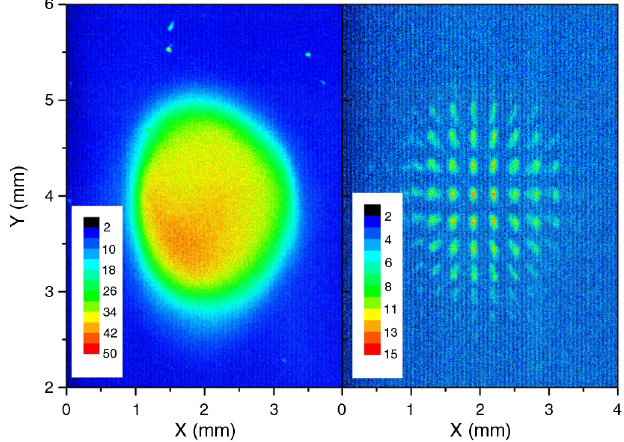
FIG. 7. Electron beam on a YAG screen in the emittance monitor (left) and when a pepper-pot mask is inserted 400 mm ¼ upstream (right) ( (cid:5) mc 2 ¼ 5 : 61 MeV ; Q ¼ 13 pC ; D laser ¼ 0 : 23 (cid:1) m ; V ¼ 300 kV ; g ¼ 6 mm ; 0 : 5 mm ; " nX pulser ¼ 4 : 2 ps Gaussian time profile; (cid:2) t; laser